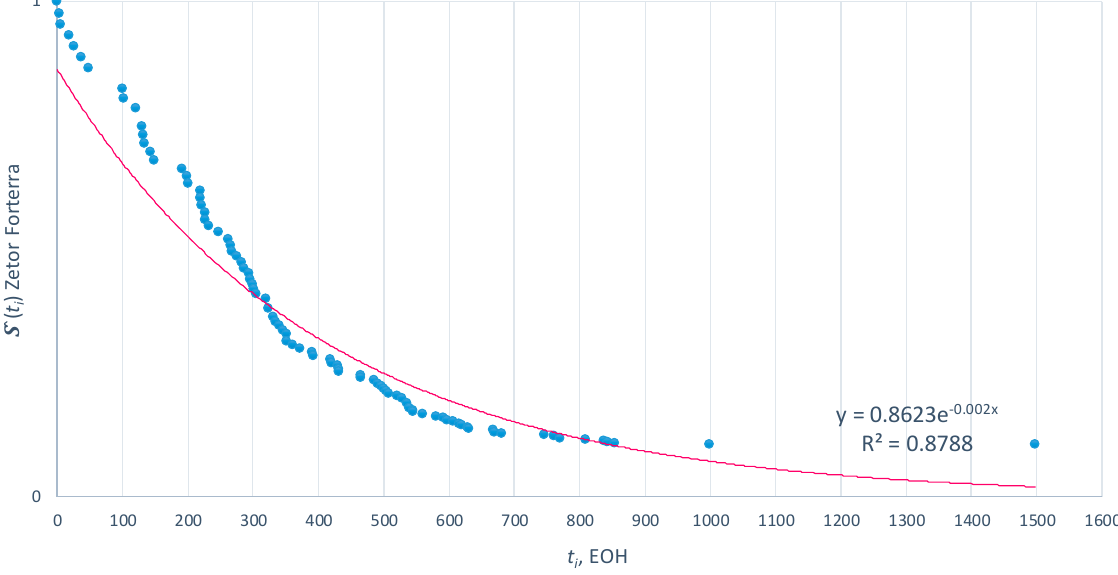
Figure 4. The K–M survival function for models of Zetor Forterra tractors, within the range of 0–1498 EOH. Own calculations made in an Excel spreadsheet.